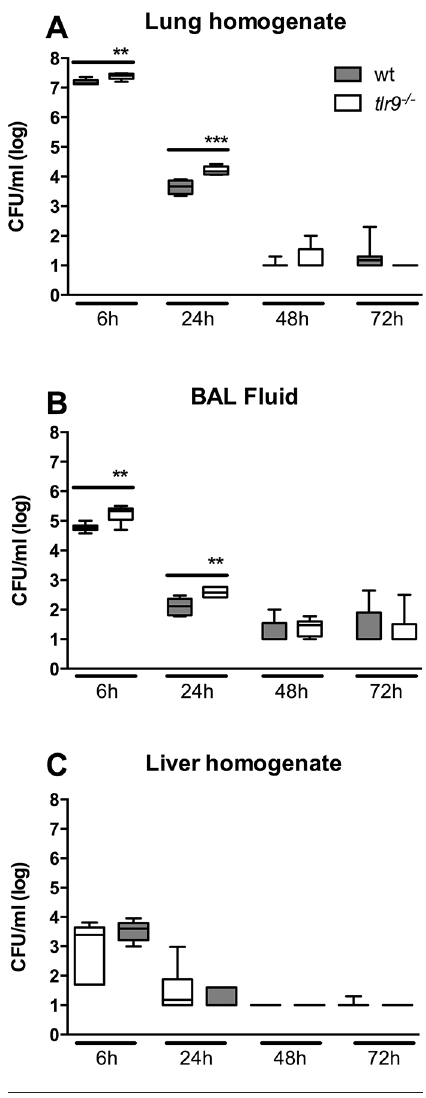
versus Wt mice at the same time